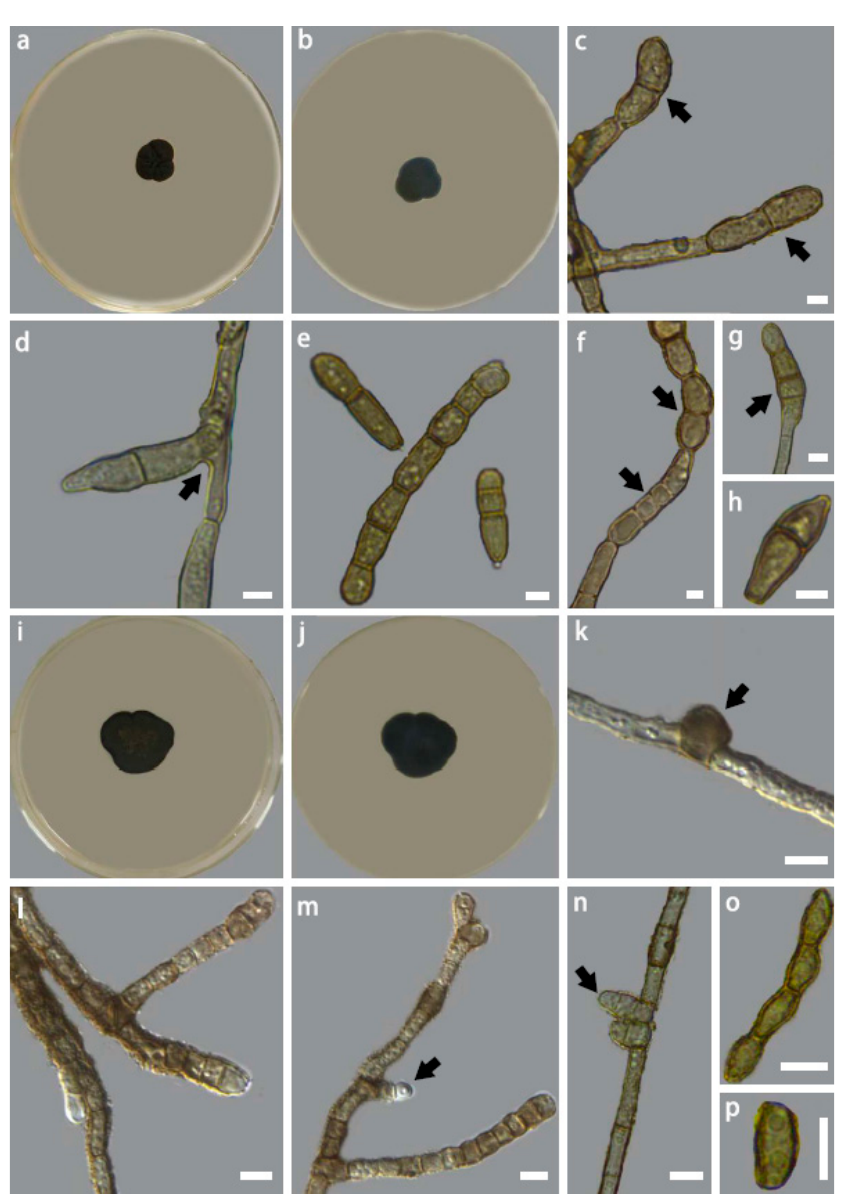
Figure 5. Colony morphology of Intumescentia pseudolivetorum sp. nov. (CGMCC3.23635) on PDA medium after 30 days at 25 °C , ( a ) top, ( b ) reverse, ( c ) hyphae with thick-walled apical conidia, ( d ) hyphae with lateral branching with basal constriction, ( e ) 2, 3, and 7-celled conidia, ( f ) chain of conidia with both columnar and fusoid conidia, ( g ) apical conidia, ( h ) a single fusoid conidium; Colony morphology of Intumescentia ceratinae sp. nov. (CGMCC3.23630) on PDA medium after 30 days at 25 °C , ( i ) top, ( j ) reverse, ( k ) asperulous hypha with intercalary swelling, ( l ) hypha with variable compartment sizes, ( m , n ) lateral conidial initials, ( o ) chain of conidia with thick walls, ( p ) conidium. Bars = 5 μ m. Morphological structures listed above are indicated with arrows.